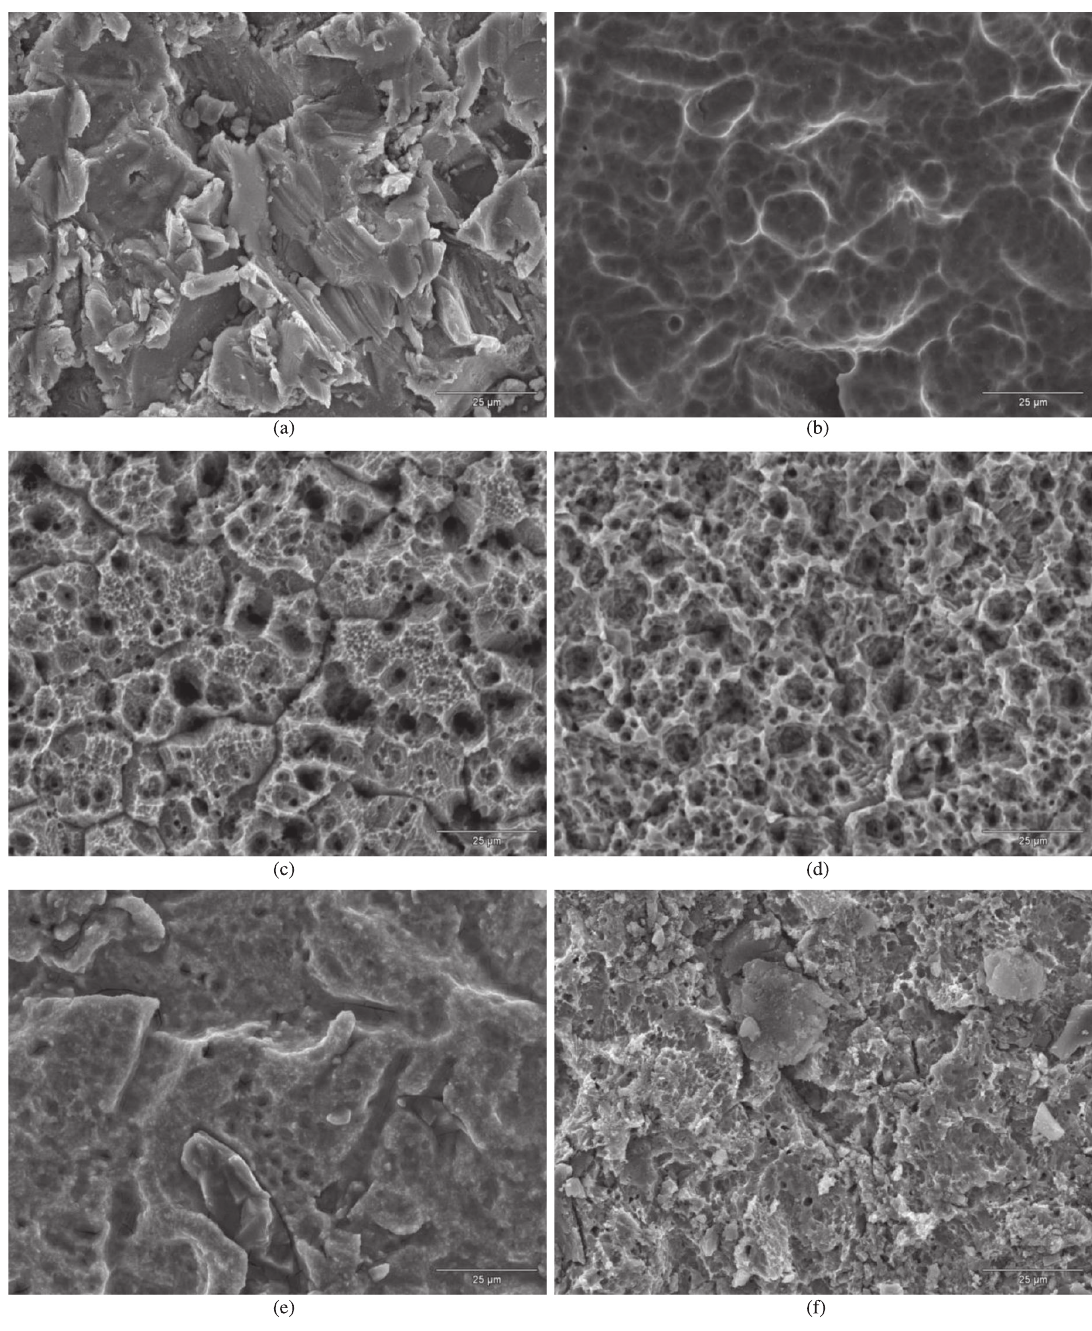
Figure 1. SEM pictures of groups control (a), AT1 (b), AT2 (c), AT3 (d), AT4 (e), and AT5 (f) (original magnification 1000 × – scale bar 25 μm).